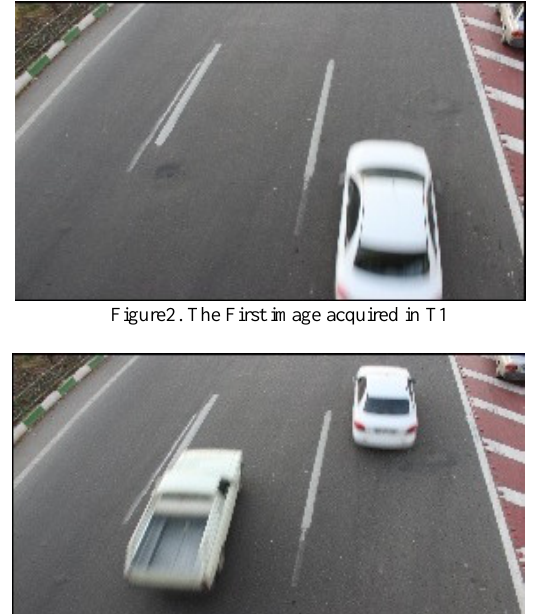
Figure3. The Second image acquired in T2